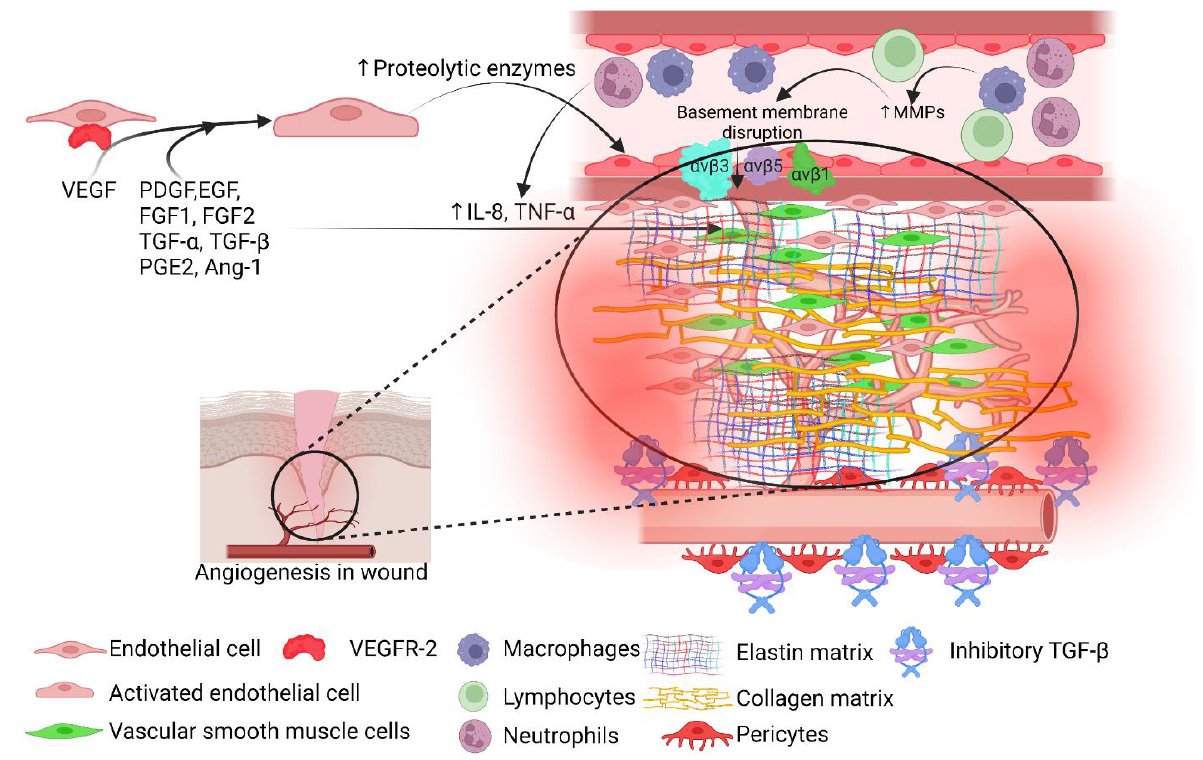
Figure 1. Angiogenesis in wound healing. Vascular endothelial growth factor (VEGF) secreted from fibroblasts in the wound environment activates endothelial cells (ECs) leading to increased secretion of proteolytic proteins. Increased matrix metalloproteinases (MMPs) from macrophages and proteolytic enzymes facilitate the disruption of the basement membrane, migration of ECs, and sprouting of the new vessels into the wound. This process is facilitated by increased expression of adhesion proteins (VCAM-1) and integrin receptors ( αvβ1, αvβ 3, and αvβ 5) and mediators of angiogenesis such as platelet-derived growth factor (PDGF), epidermal growth factor (EGF), fibroblasts growth factor (FGF), transforming growth factor (TGF)- α and β , prostaglandin E2 (PGE2), angiotensin (Ang)-1, interleukin (IL)-8, and tumor necrosis factor (TNF)- α. Increased recruitment of vascular smooth muscle cells (VSMCs) and pericytes facilitate neo-angiogenesis and vasculogenesis. Once vessels are formed and wound healing enters the later phase of healing angiogenesis is suppressed by the inhibitory form of TGF- β and increased secret ion of endostatin (collagen XVIII).